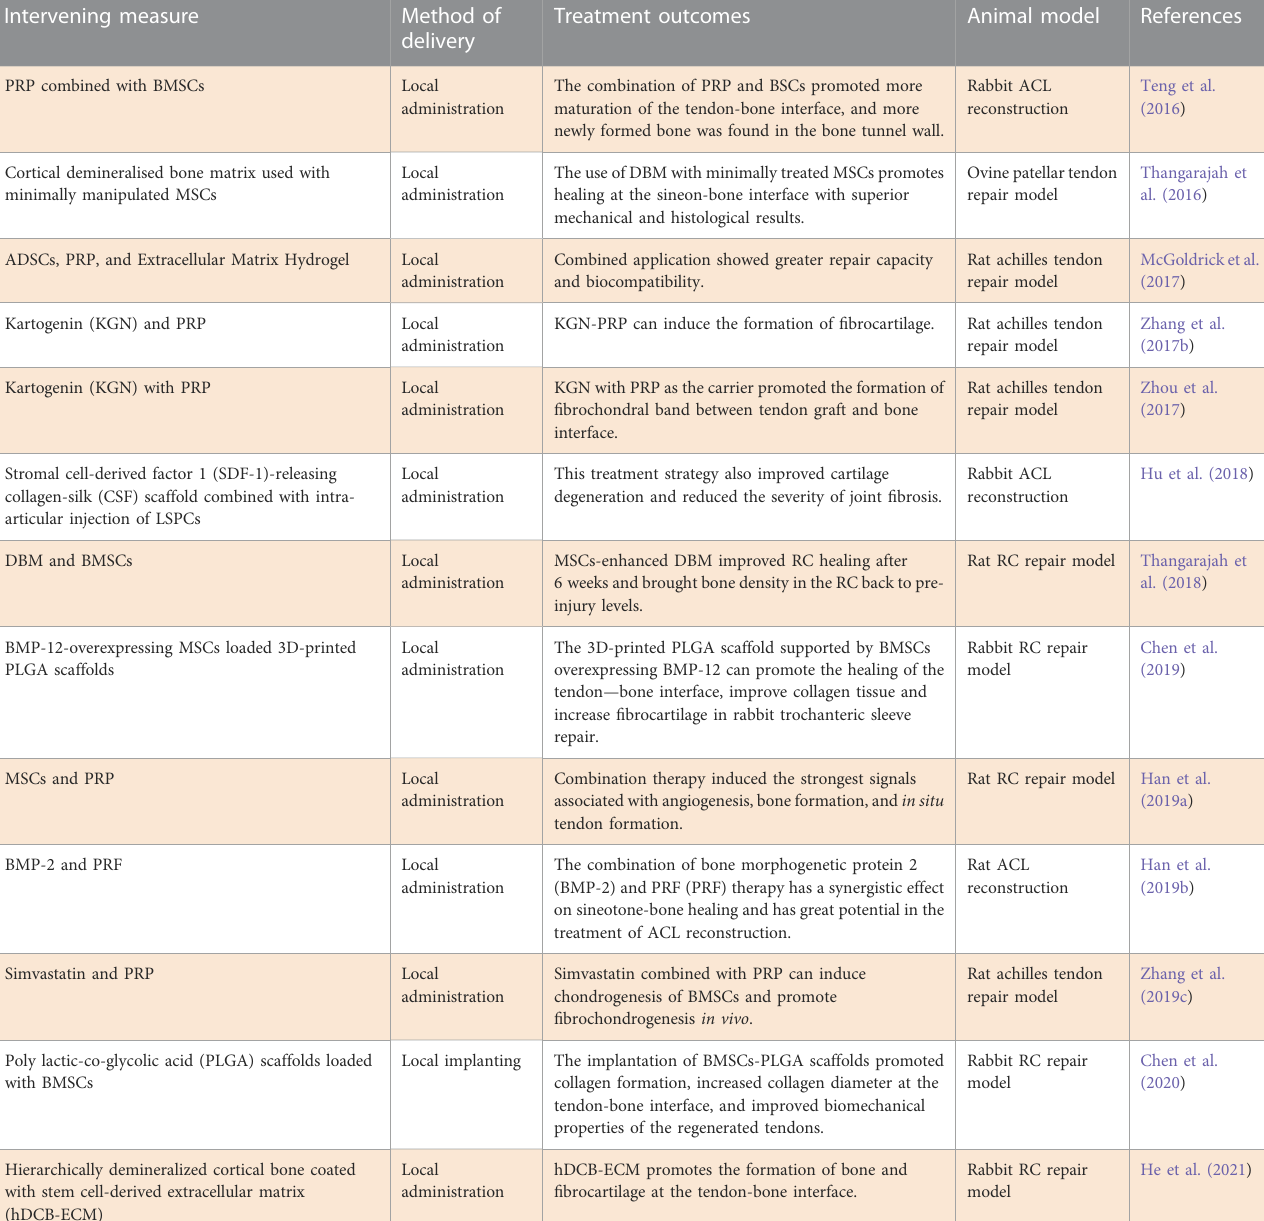
TABLE 7 Preclinical studies of combined application in promoting tendon-bone